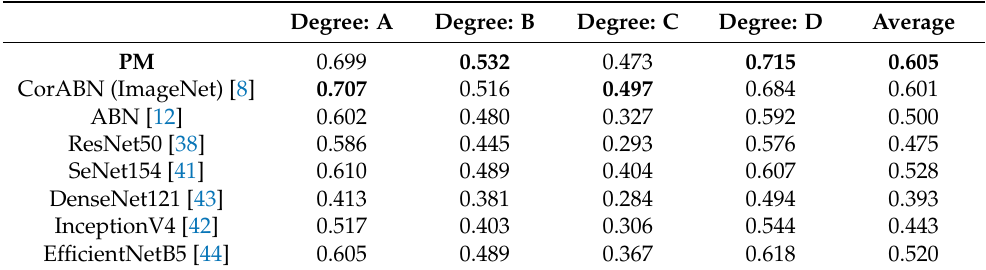
Table 7. F1-scores of PM and CMs in the distress type of efflorescence. The best scores for each degree and the average are depicted in bold.